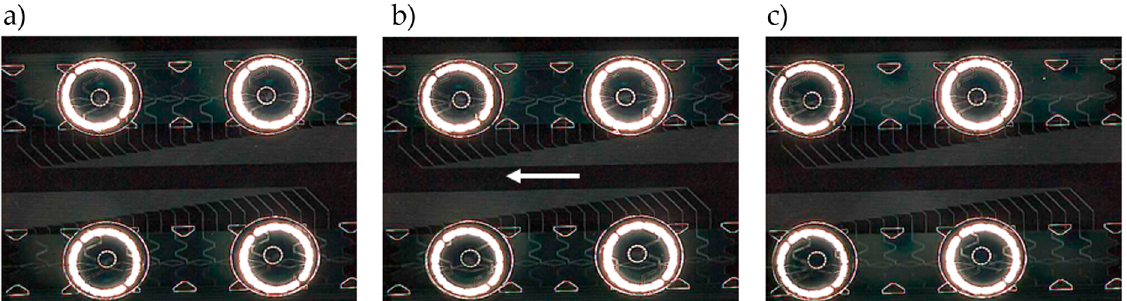
Figure 22. Four droplets moved synchronously from one stable position to the next. ( a ) Four droplets positioned between the photoresist barriers; ( b ) initial movement of the droplets; ( c ) four droplets reaching the next stable position, as de fi ned by the photoresist structures.